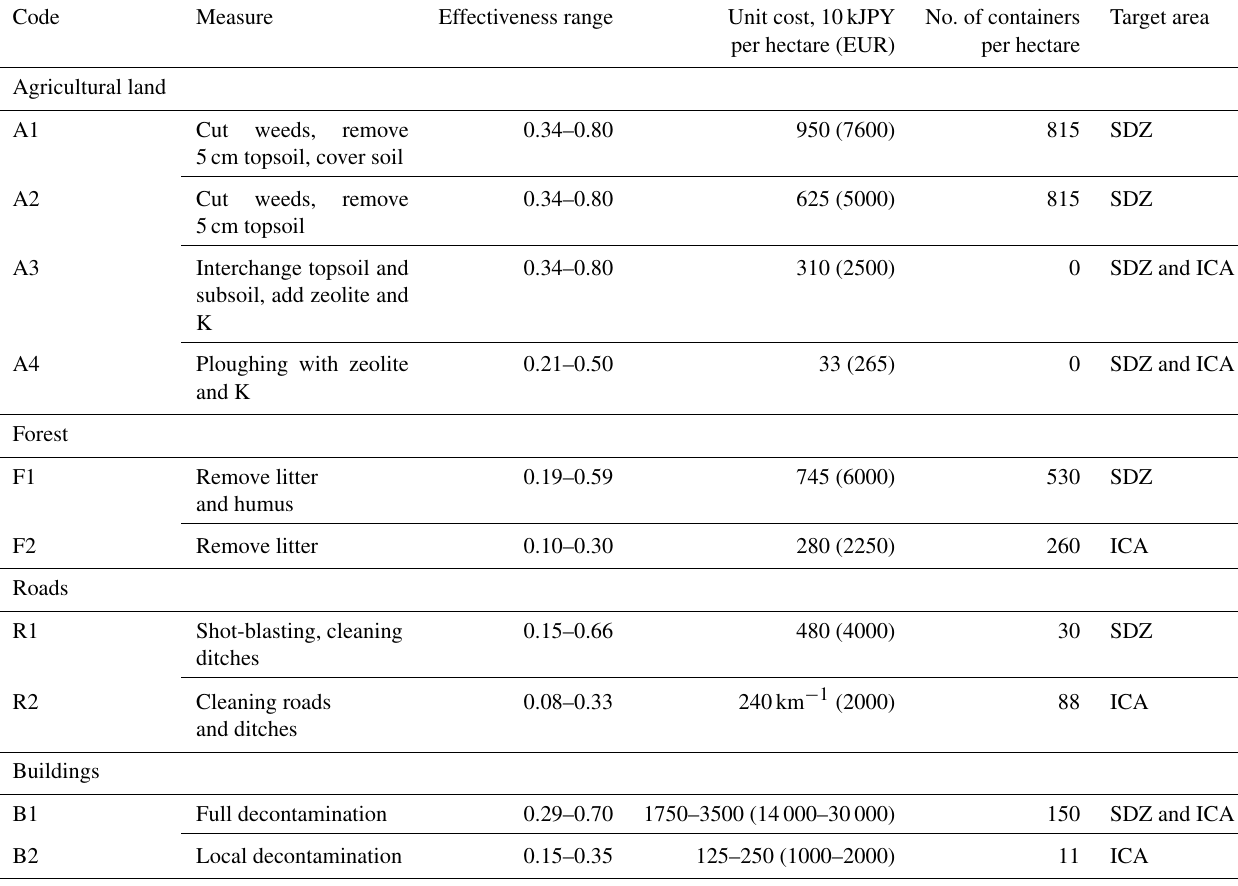
Table 2. Unit costs and effectiveness of decontamination measures implemented in the SDZ and ICAs after Yasutaka and Naito (2016).